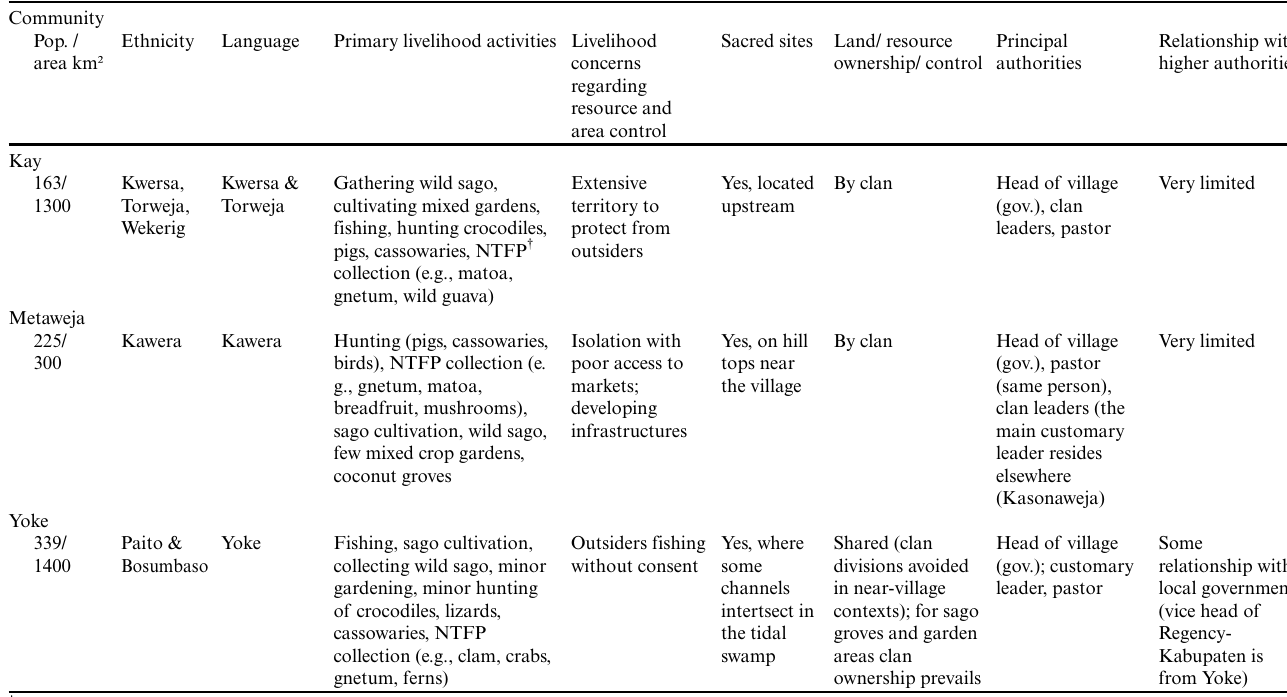
Table 1 . The three communities considered in the Mamberamo Watershed (Papua, Indonesia): their populations, territories, ethnicity and languages, livelihood, livelihood concerns (as stated in focus group discussions), how land and resources are determined, authority, and relationship with government